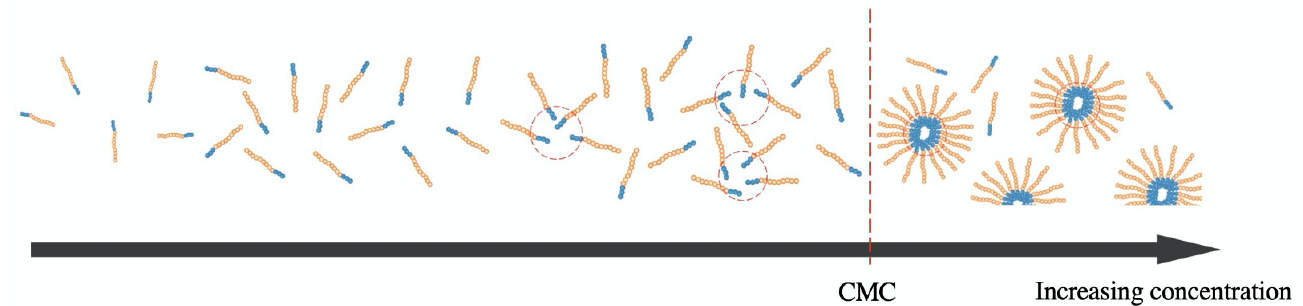
Figure 1. Illustration of micellar aggregate forming with increasing concentrations. The blue end is the insoluble block end while the orange is the soluble block end.